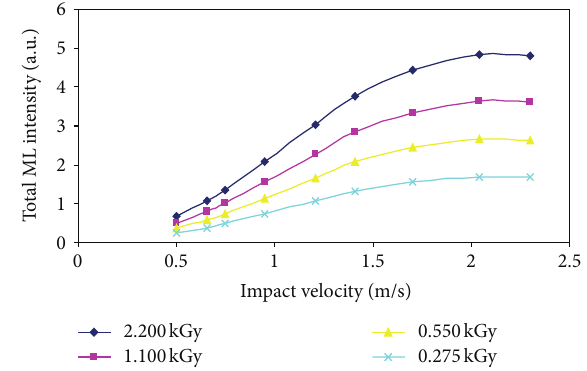
Figure 6: Dependence of ML intensity of MgAl 2 O 4 : Dy (0.1mol%) phosphor on impact velocity for different gamma